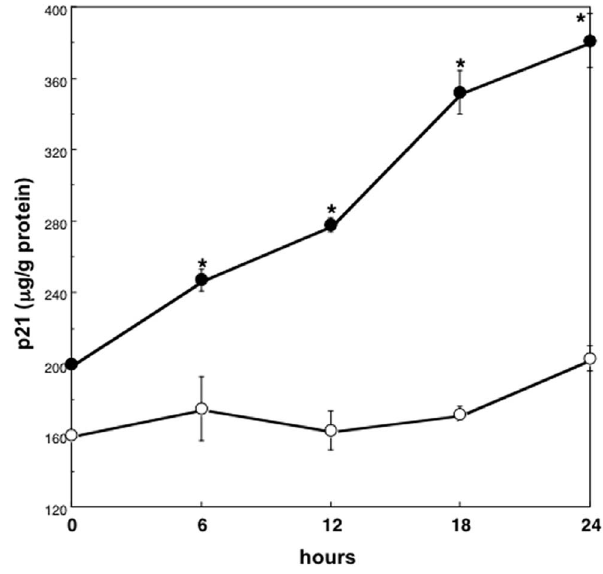
Figure 3. Serial changes in p21 protein levels of hepatocytes treated with HGF. Rat hepatocytes were cultured at high density in WE containing 10% FCS and 10 ng/mL HGF, and were harvested serially. Closed circles denote hepatocytes cultured at high density. Open circles denote hepatocytes cultured at low density. Data are mean 6 SEM of four dishes. *p , 0.01 compared with the values cultured for 0 hours.